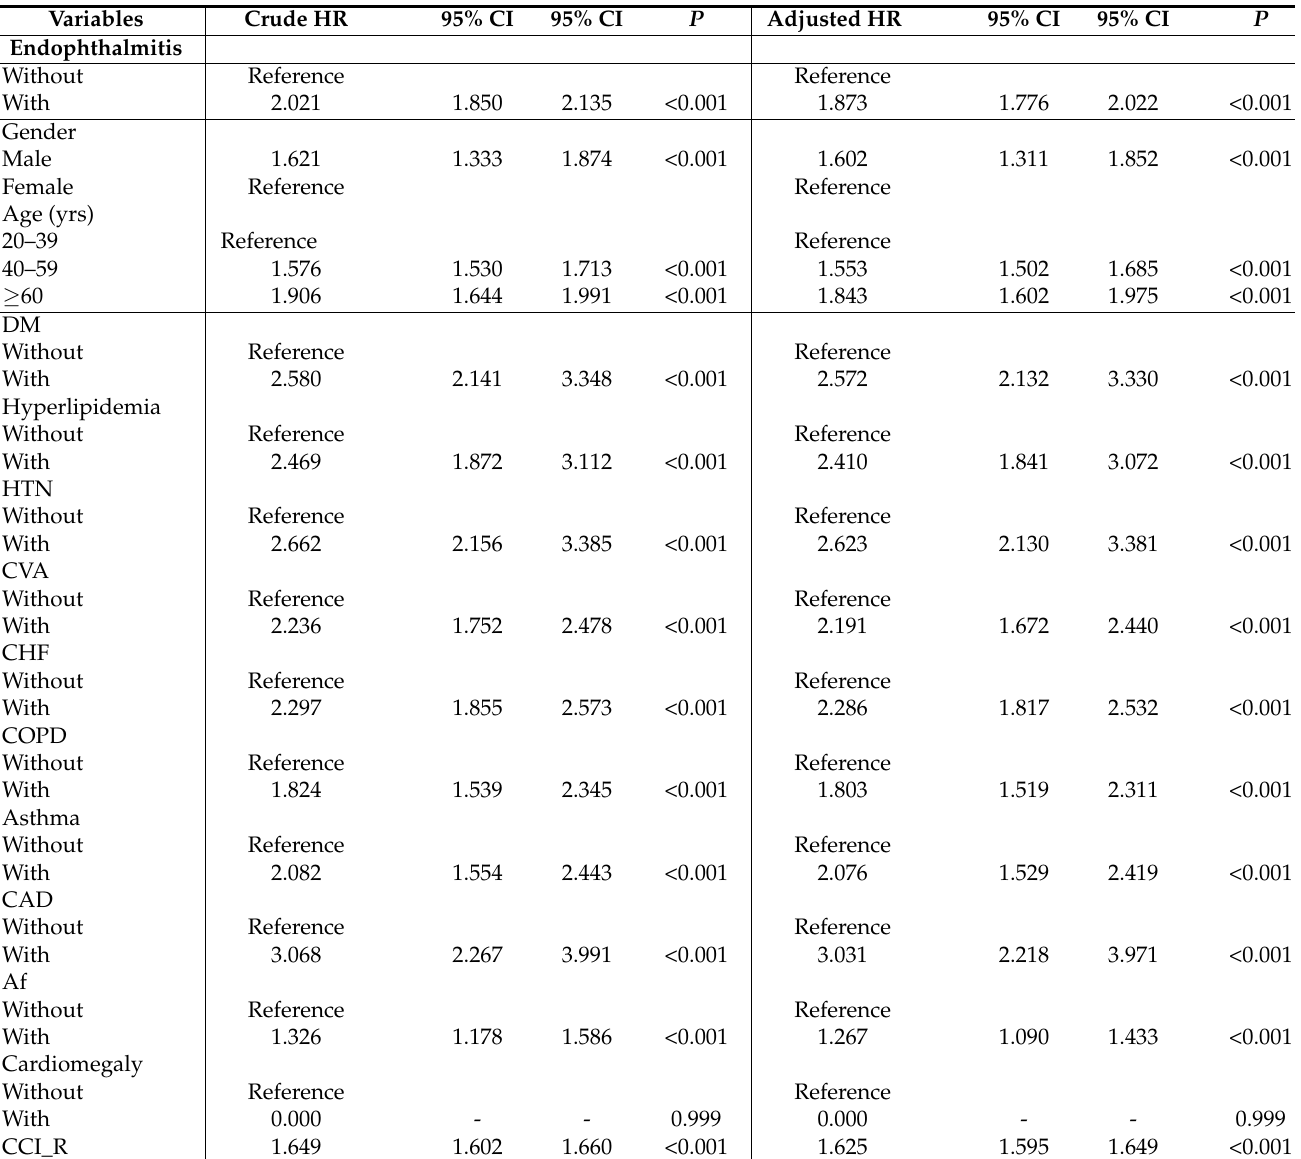
Table 3. Factors of stroke by using Cox regression